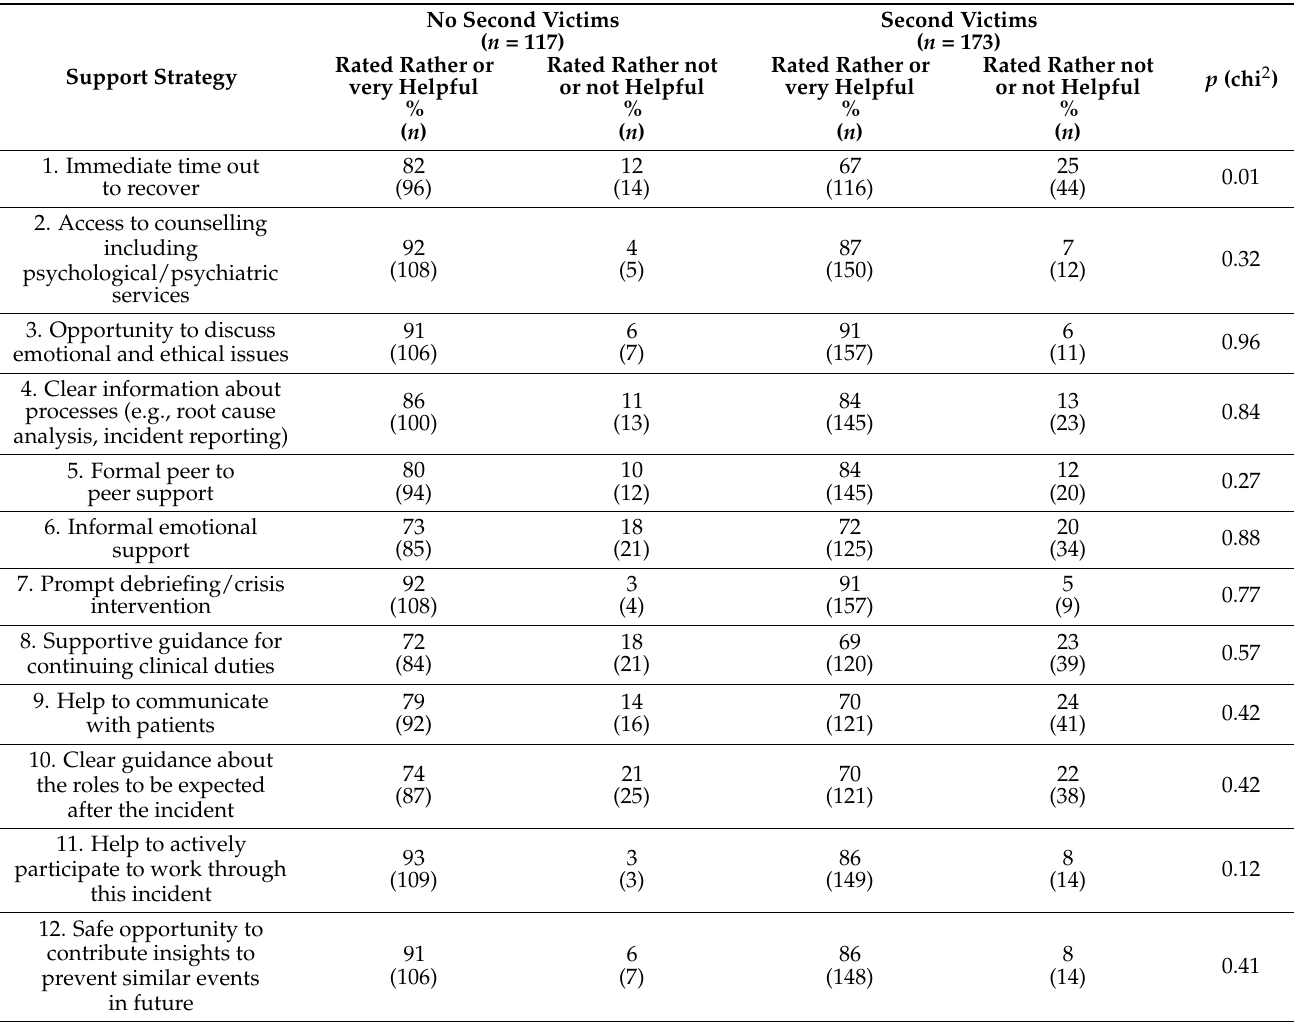
Table 6. Rating of support strategies by participants with and without having experienced second victim incidents.